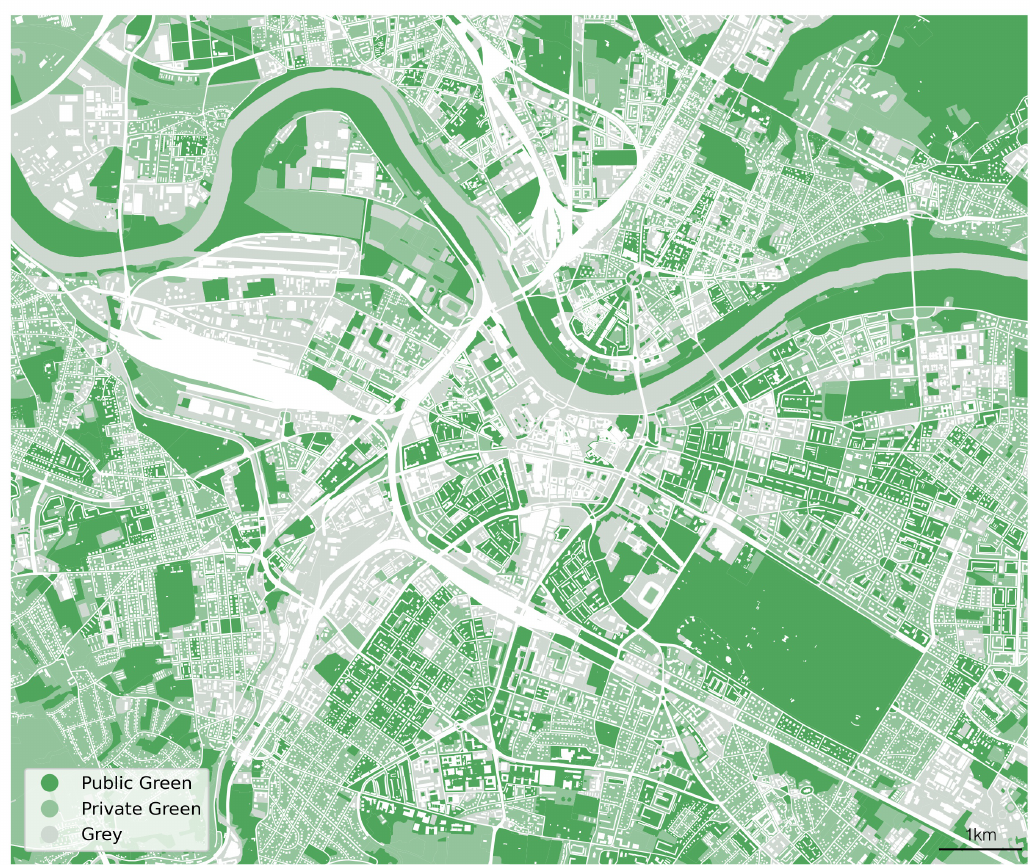
Figure 10. Public and private green spaces in the center of Dresden mapped using the proposed method. The classes ( public , grey ) and ( private , grey ) were merged to the class grey